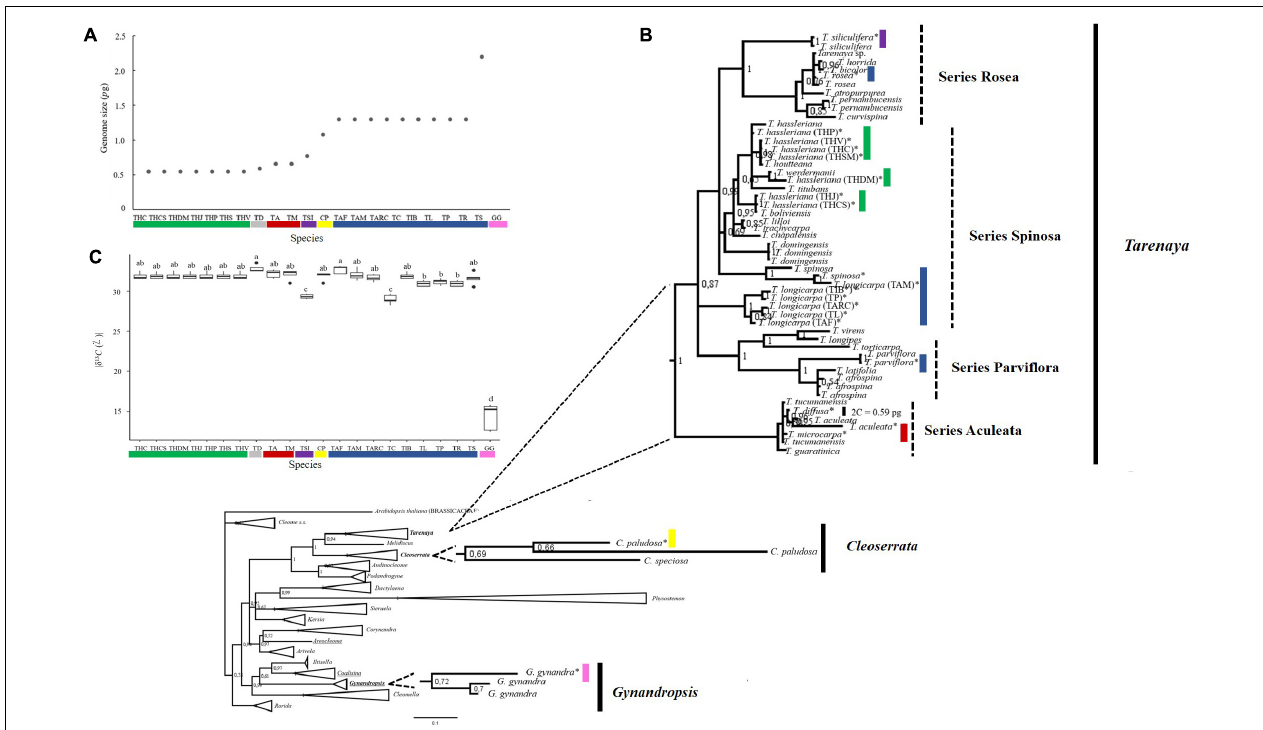
FIGURE 2 | Genome size, carbon isotopic composition and molecular phylogeny of Cleomaceae species. (A) Genome size. (B) Bayesian Inference consensus tree inferred from nuclear ribosomal ITS sequences retrieved from Cleomaceae and Brassicaceae members, demonstrating the phylogenetic relationship between Cleomaceae genera. Underlined sequences represent genera that have species with C 4 photosynthetic metabolism ( Gynandropsis, Coalisina, and Areocleome ). In bold are the genera analyzed in this study ( Tarenaya , Cleoserrata, and Gynandropsis ). The sequences generated in this study are marked with an asterisk. In addition, the 2C nuclear value for each species (group) was added following its identification. The colors represent different genome sizes, as described in (A) . Numbers at nodes reflect PP. Bar: 0.2 nucleotide substitutions per site. (C) Carbon isotope composition ( δ 13 C; • / •• ). Letters above individual box-scatter indicate significant groupings according to Tukey’s Test ( n = 5). The median is indicated by solid lines in each box; data dispersion is represented by the interquartile range, followed by standard error and outliers. Species studied: The acronyms are those described in Figure 1